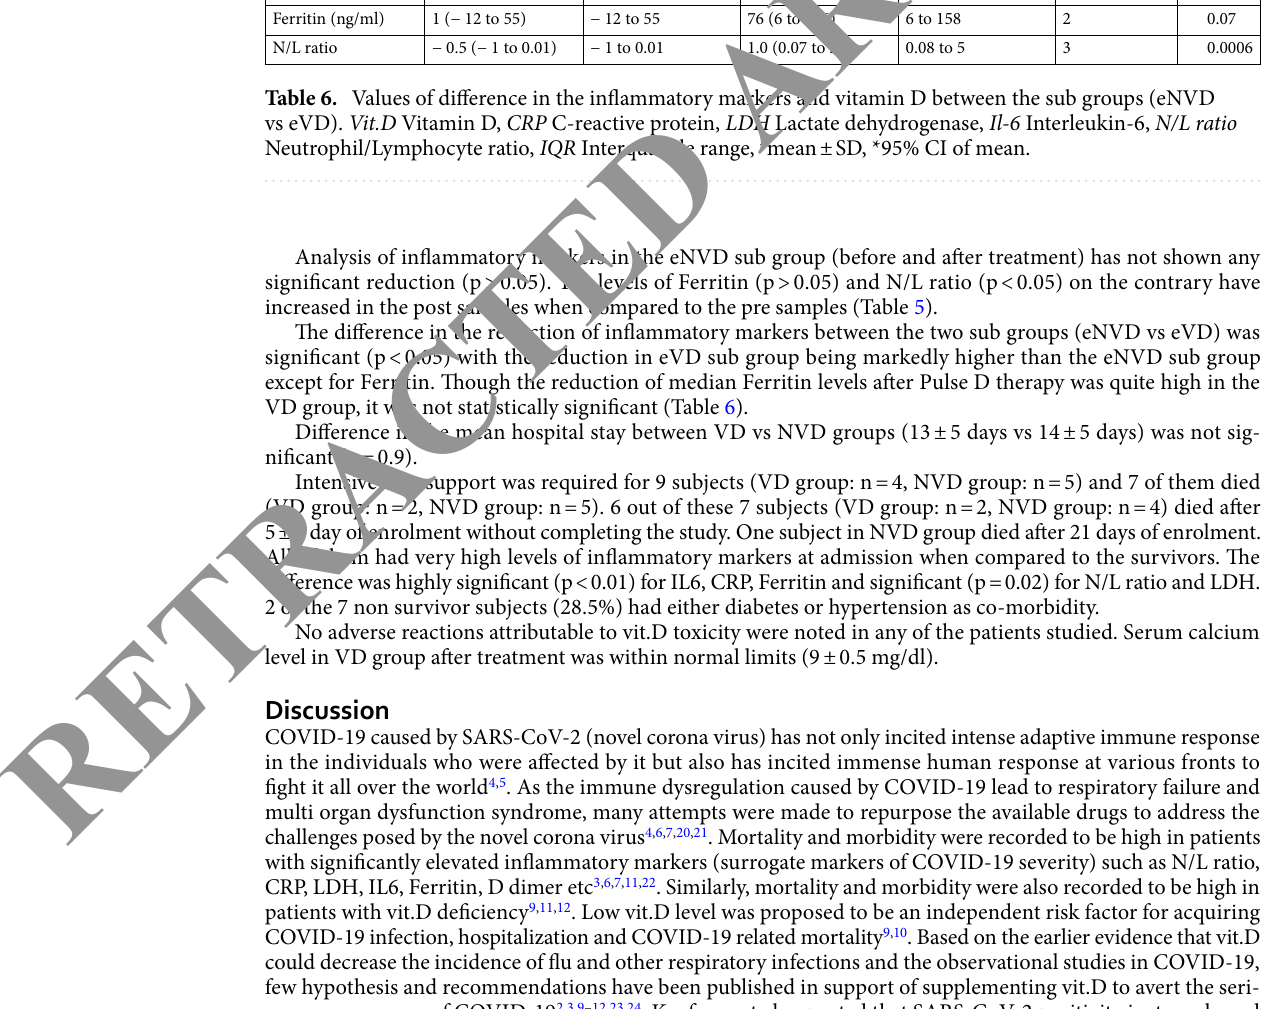
Difference in in